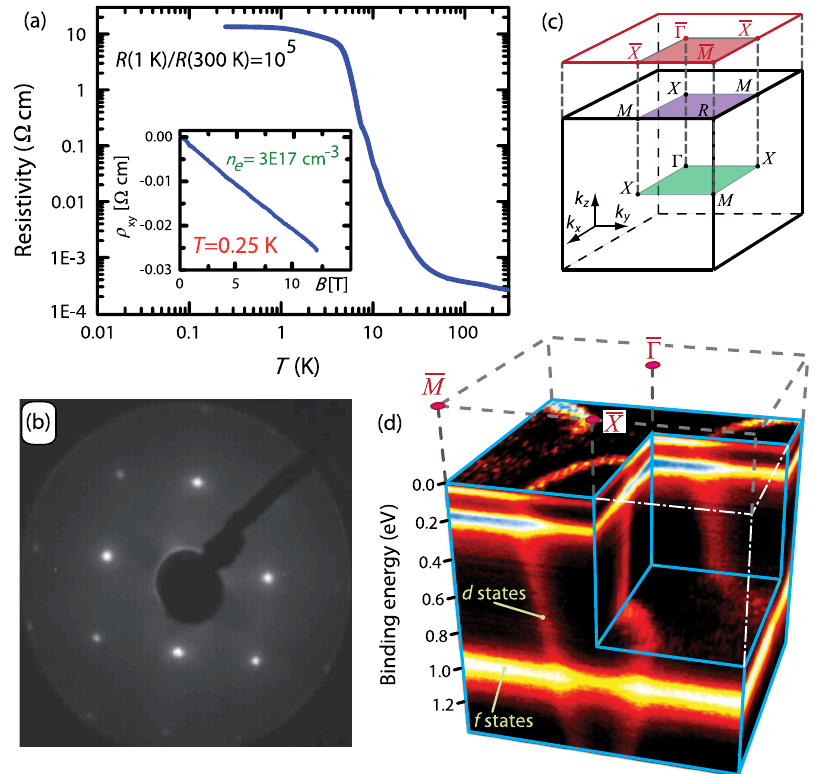
FIG. 1. SmB 6 transport, surface quality, and ARPES data overview. (a) Temperature dependence of the resistivity of a floating-zone, optical-furnace-grown SmB 6 crystal. There is a sharp increase below 50 K that results in a very high resistivity ratio of 10 5 between the saturation regime and room temperature. The inset shows the Hall resistivity, which is linear, yielding an n -type carrier concentration as indicated (low T regime). (b) Very sharp LEED spots reflect the simple ( 1 (cid:2) 1 ) surface structure—free of reconstructions—and attest to the long-range order of the cleavage surface. The LEED primary beam energy is 97 eV. (c) Sketch of the 3D Brillouin zone of SmB 6 and its projection onto the (001) plane. The colored planes denote the relevant cuts through the zone that would be made for photon energies in ARPES corresponding to a k z value of an even number of (cid:2)=a (green plane), an odd number of (cid:2)=a (purple plane), and the surface projection (red plane). (d) Three-dimensional ARPES data block displaying I ð E B ; k x ; k y Þ . Two types of bands are seen with the strongly dispersing (flat) bands originating from Sm 5 d ( 4 f ) states, as indicated. The Sm 5 d -related states give rise to elliptical contours at higher binding energies (the cutaway in the lower-right corner of the data block showing contours for a binding energy of (cid:2) X 0.8 eV), which then evolve to give elliptical Fermi-surface contours around the points. These states are discussed in the text as the X states and are argued to be essentially bulk-derived bands, well described by bulk, ab initio theoretical approaches. Where the flat 4 f bands intersect the 5 d -dominated X states, complex band structures result because of the hybridization effects between d and f states of the equal symmetry, as will be discussed in detail in the context of Fig. 2. The photon energy for the data block is h(cid:1) ¼ 70 eV